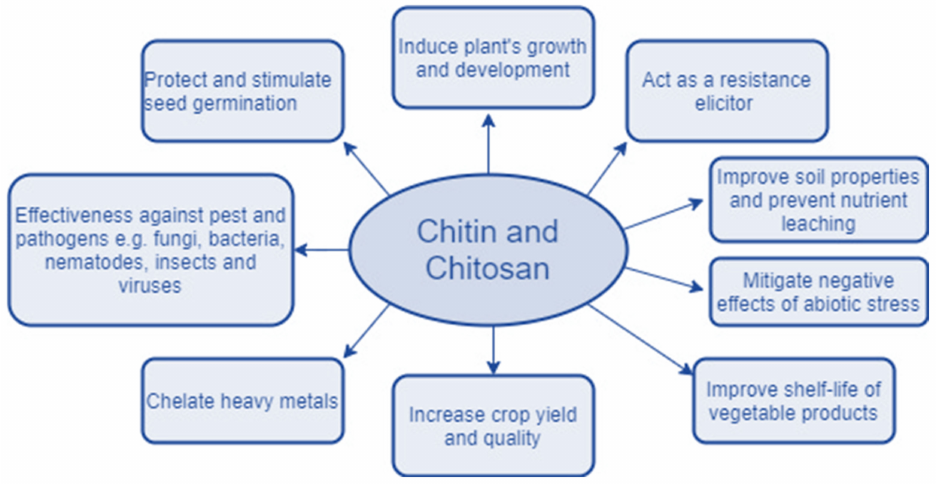
Figure 25. Possible applications of chitin and chitosan in agriculture